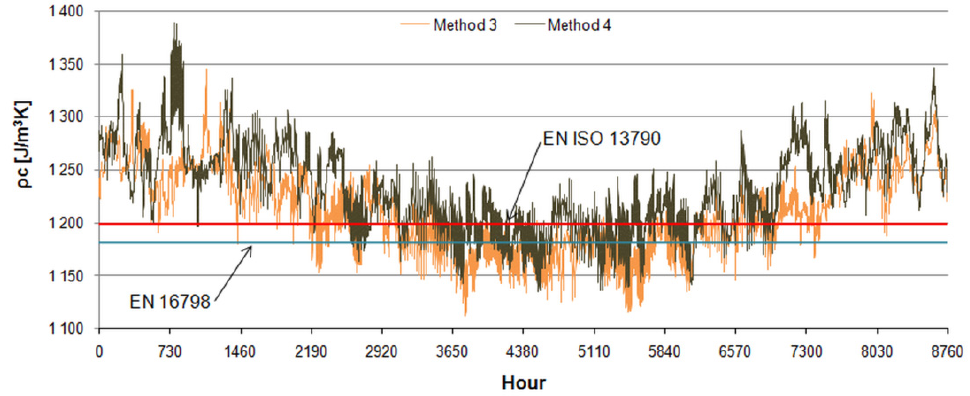
Figure 10. Volumetric specific